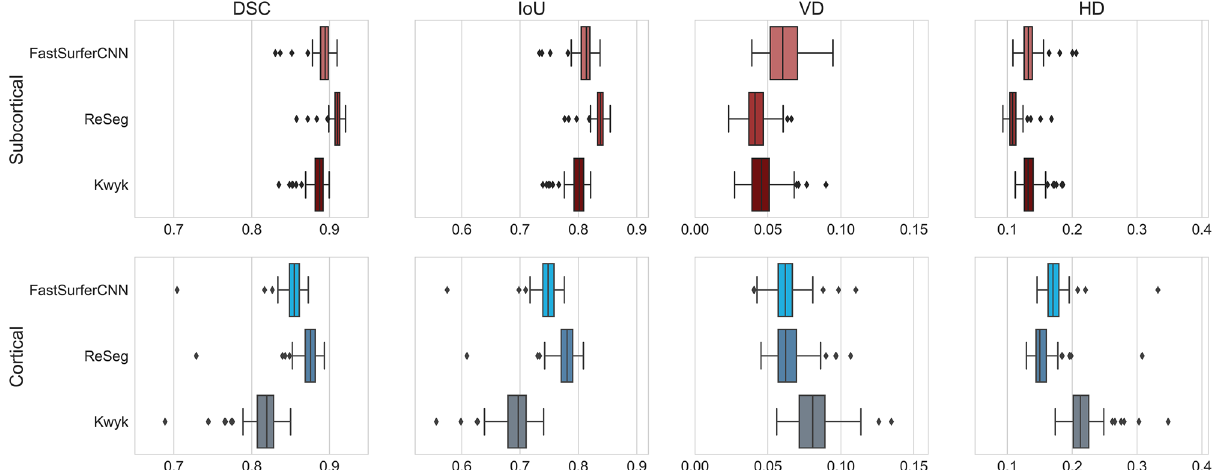
Figure 2. Boxplots showing the distributions of the dice similarity coefficient (DSC), intersection over union (IoU), volumetric difference (DF), and Hausdorff distance (HD) for the deep learning-based segmentation methods. Evaluation metrics were calculated to compare segmentation masks generated by the deep learning- based segmentation methods to those generated by